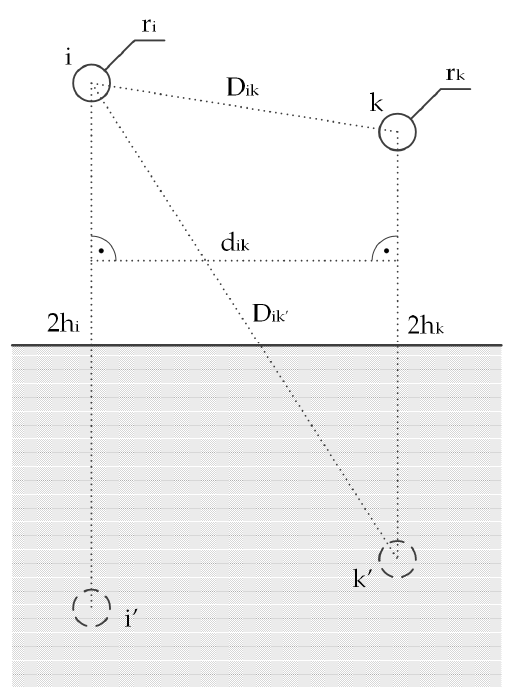
Figure 1. Configuration of the two-wire system above ground as introduced by Carson. All the symbols represent the distances between the conductors “ i ” and “ k ”, and their mirror images in the ground.